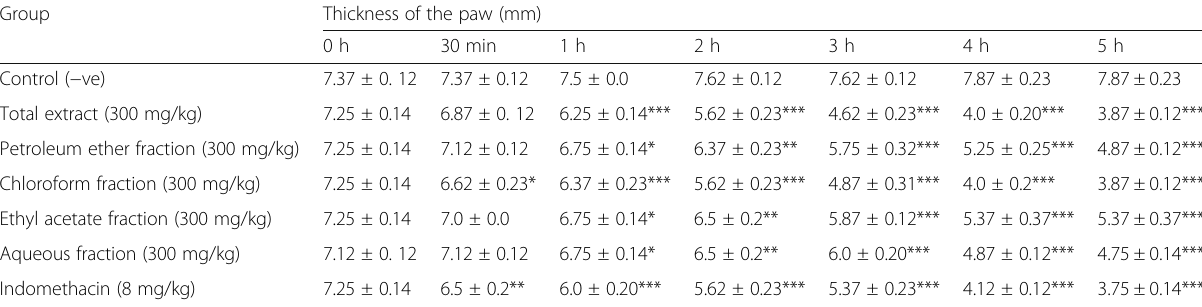
Table 1 Results of the anti-inflammatory activity of the total ethanolic extract and different fractions of A. hirtum leave using carrageenan – induced paw edema method Group